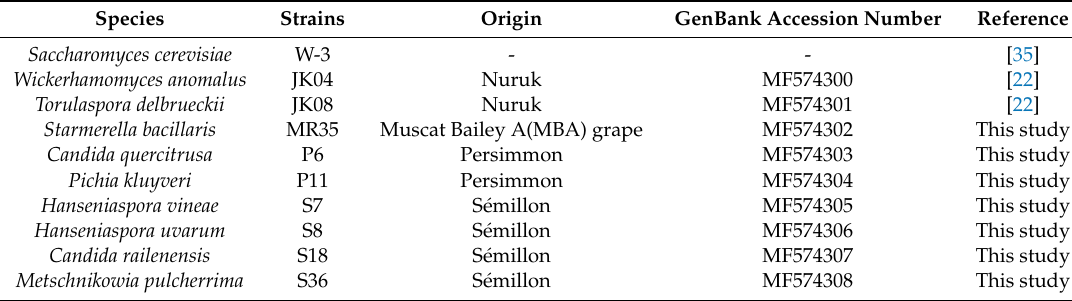
Table 1. Strains used in this